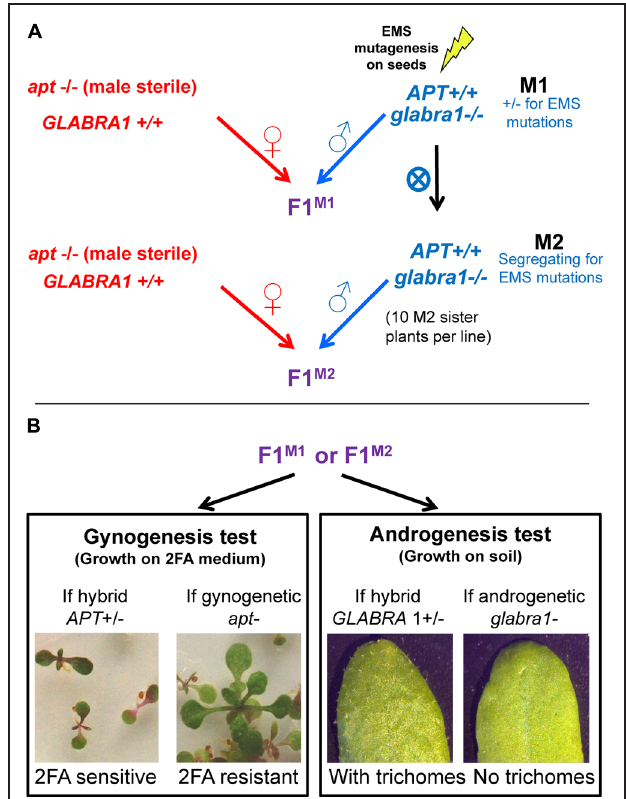
FIGURE 1 | Design of the haploid inducer screen. Seeds of Col-0 strains containing the glabra1 mutation are mutagenized to obtain M1 plants which are self-fertilized to produce M2 plants. These plants, either in M1 or M2, are crossed with an apt mutant (A) . The two mutations, apt and glabra1 are recessive and confer resistance to 2FA and absence of trichomes, respectively (B) . In F1, if gynogenesis or androgenesis haploids appear they would lack APT or GLABRA dominant allele, respectively, and be detected because of the corresponding phenotype.